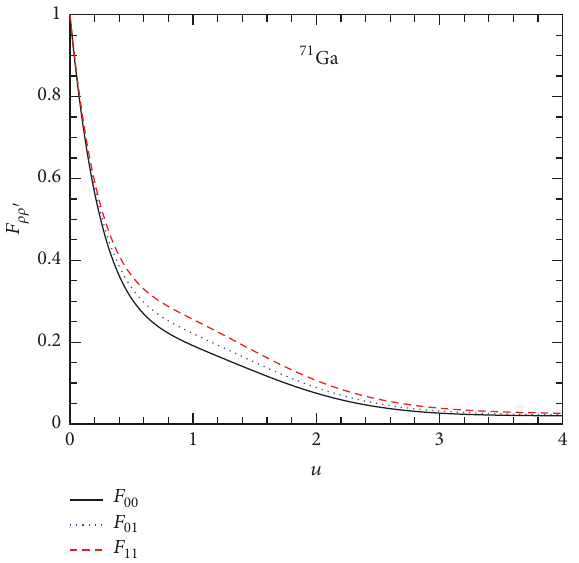
Figure 6: Normalised spin structure functions of 71 Ga for the ground state.